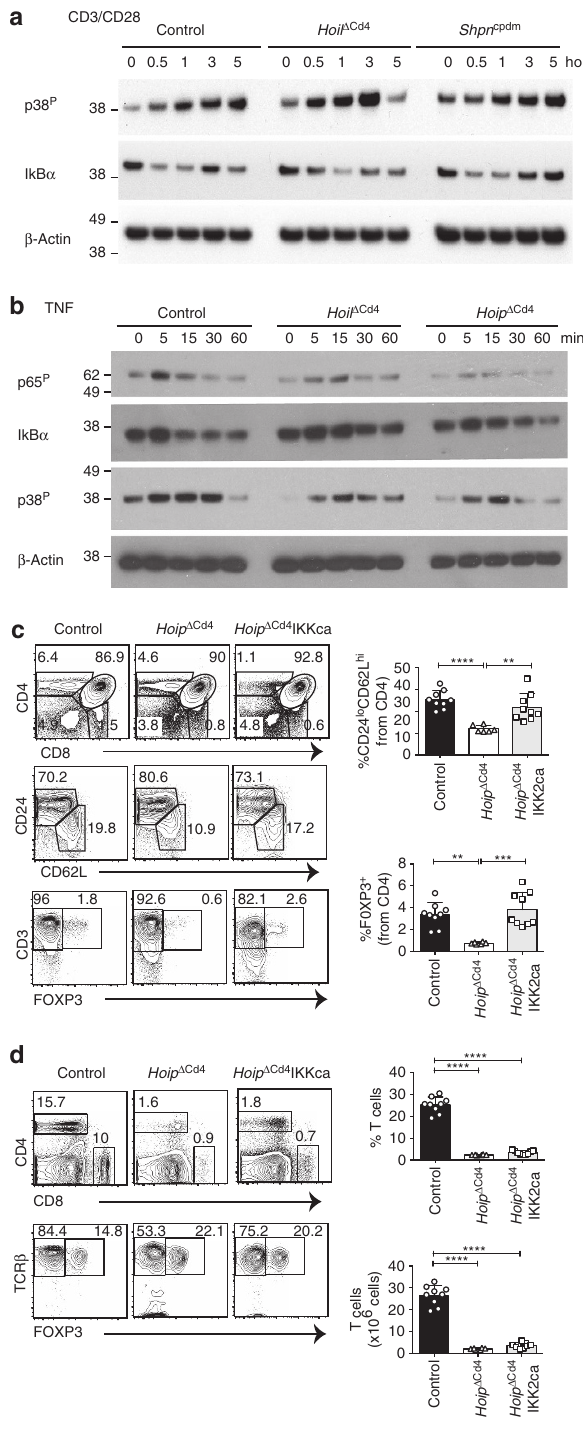
Figure 4 | Perturbed TCR or TNFR signalling in LUBAC-deficient thymocytes. Immunoblot analysis of phosphorylated (activated) p38, phosphorylated (activated) p65 or total I k B a from thymocytes left unstimulated (0) or stimulated with anti-CD3/CD28 for 0.5, 1, 3 or 5h ( a ) or with TNF for 5, 15, 30 or 60min ( b ). ( c ) Surface staining of CD4 and CD8 (upper panels), CD24 and CD62L gated on CD4 þ cells (middle panels), CD3 and FOXP3 gated on CD4 þ cells (lower panels) and numerical quantification of thymocytes from 7- to 15-week-old control, Hoip D Cd4 and Hoip D Cd4 IKKca mice. ( d ) Surface expression of CD4 and CD8 (upper panels), TCR b and FOXP3 (lower panels) on splenocytes from control, Hoip D Cd4 and Hoip D Cd4 IKKca mice. For a and b , data are representative of two independent experiments with one mouse per group. For c and d , each symbol represents an individual mouse; small horizontal lines indicate mean ± s.d.; * P o 0.05, ** P o 0.01, *** P o 0.005 and **** P o 0.001, respectively. One-way analysis of variance with a Tukey’s post-hoc test for multiple comparisons was used for statistical analysis. Data are pooled from three independent experiments with two to five mice per group ( c , d